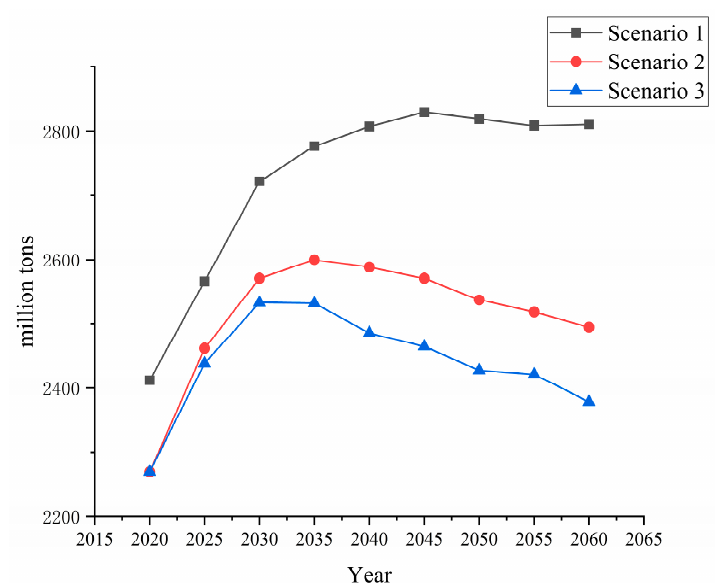
Figure 5. Upper limit of carbon emission from construction industry (million tons).